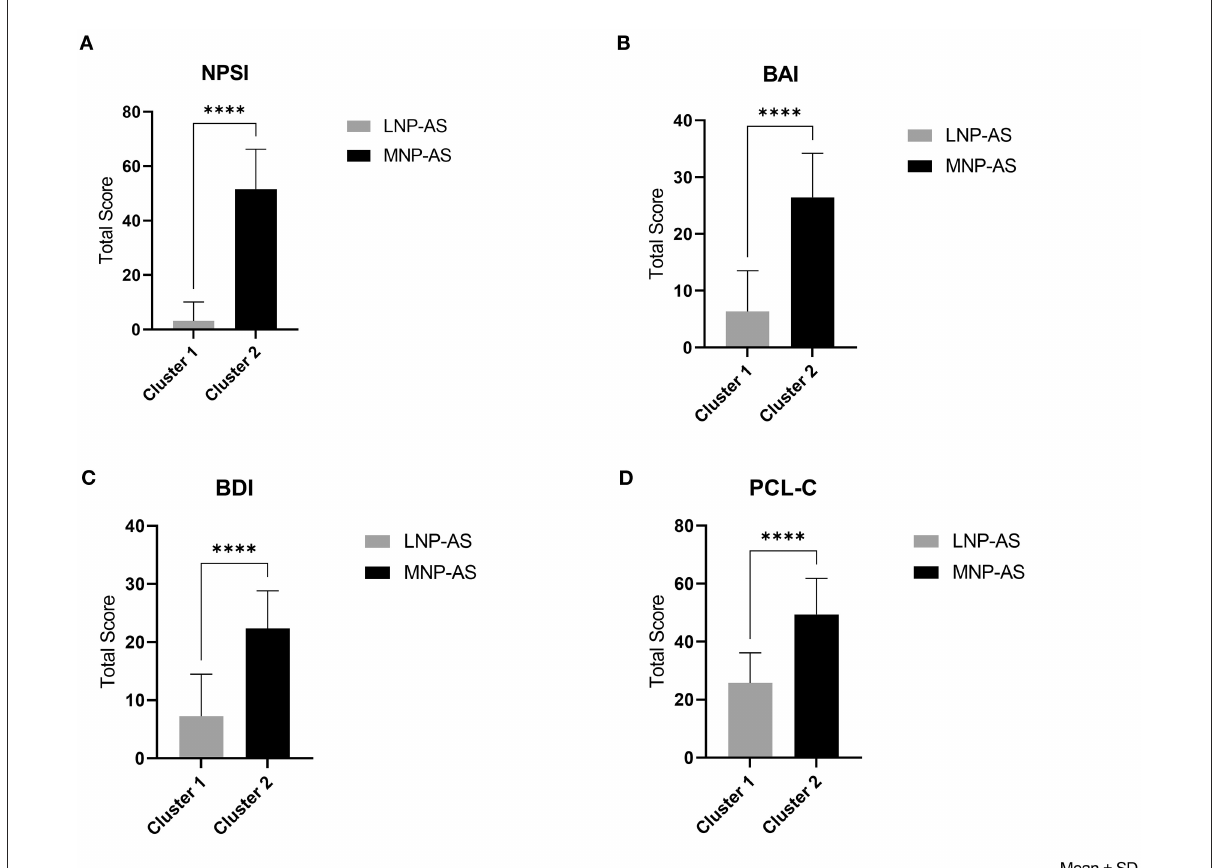
FIGURE1 Cluster analysis and validation. Clusters were compared on: (A) NPSI (neuropathic pain symptom inventory), (B) BAI (Beck Anxiety Inventory), (C) BDI (Beck Depression Inventory), and (D) PCL-C (Post-traumatic Stress Disorder Checklist-Civilian version) total scores. **** p <